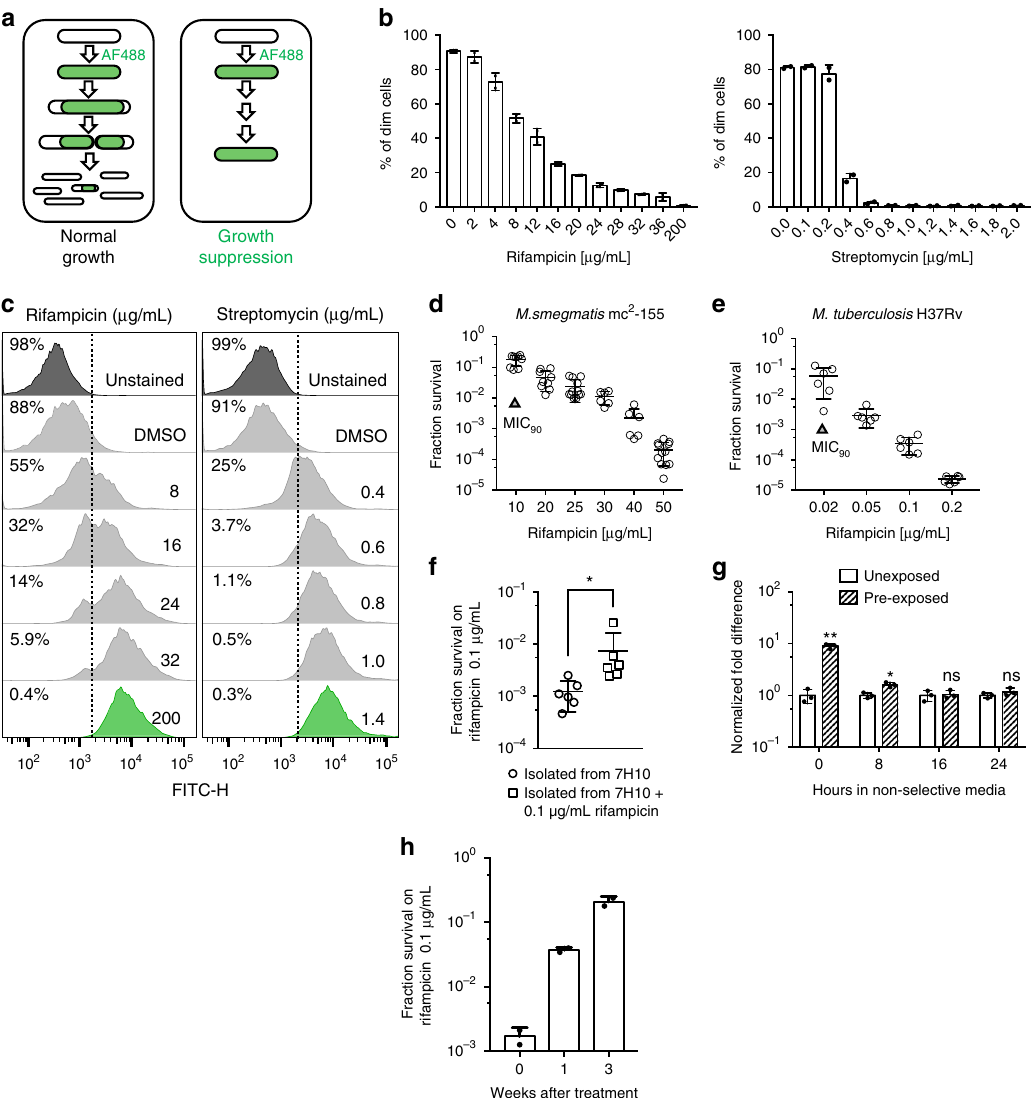
Fig. 1 Rifampicin-tolerant mycobacteria grow in bulk-lethal concentrations of antibiotic in a concentration-dependent manner. a Schematic outlining the basis for the fl uorescence dilution assay: cells are stained with Alexa- fl uor-488 (AF488), and as they grow and divide, the total fl uorescence is diluted (left panel). If cells fail to grow — either due to death or a non-replicating physiological state, full fl uorescence is retained (right panel). b Fluorescence dilution assay of M. smegmatis exposed to indicated concentrations of rifampicin (left) and streptomycin (right) and analyzed by fl ow cytometry (see Supplementary Fig. 2 for fl ow cytometry strategy for scoring dim cells). Bars represent duplicate experiments. c Sample fl ow cytometry histograms of fl uorescence distributions of single M. smegmatis cells following 16-h exposure to rifampicin (left panel) or streptomycin (right panel) at indicated concentrations. M. smegmatis ( d ) or M. tuberculosis ( e ) were plated on rifampicin-agar at varying concentrations and the fractional survival (number